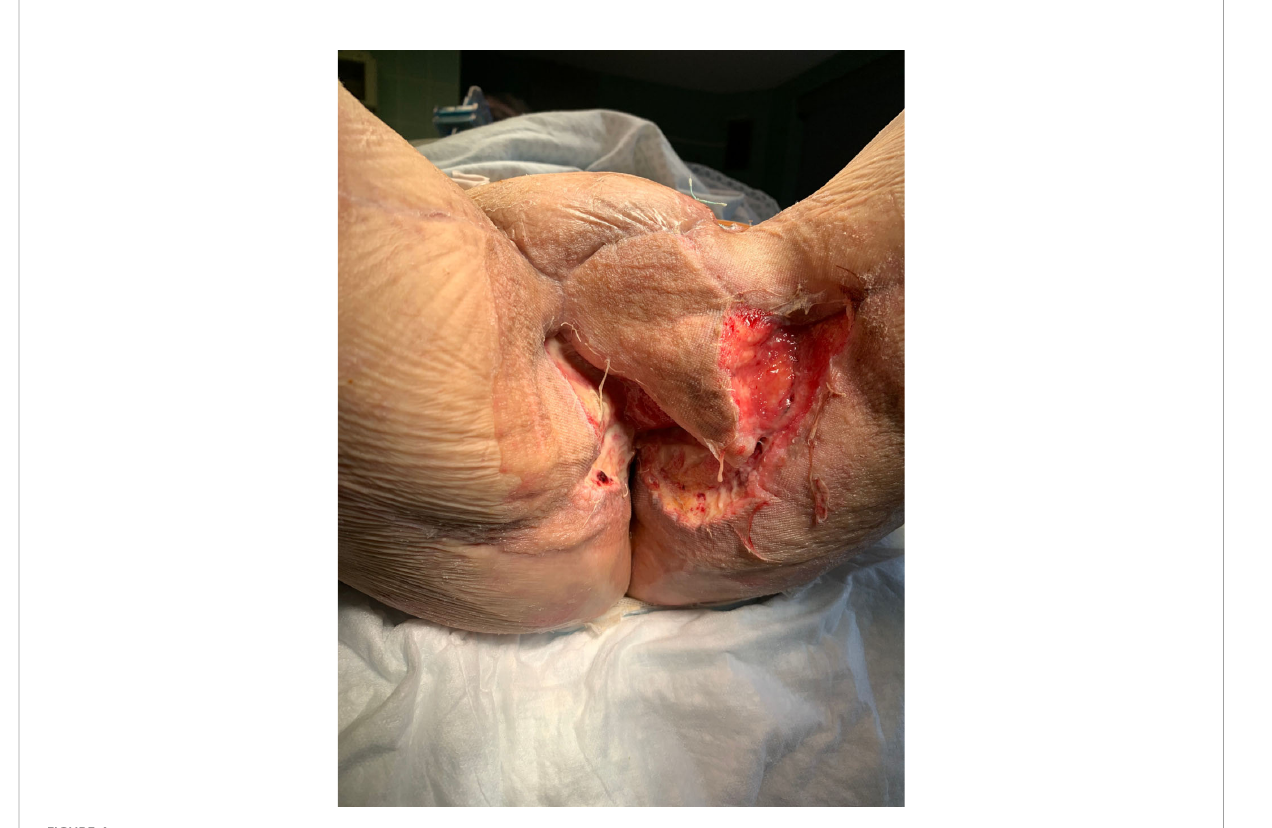
FIGURE 4 Effect of human amniotic membrane after two